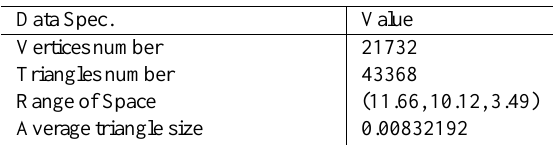
During the process of Section 5.2 an adjacent graph of a trian- gle mesh with 18 connected components constructed.